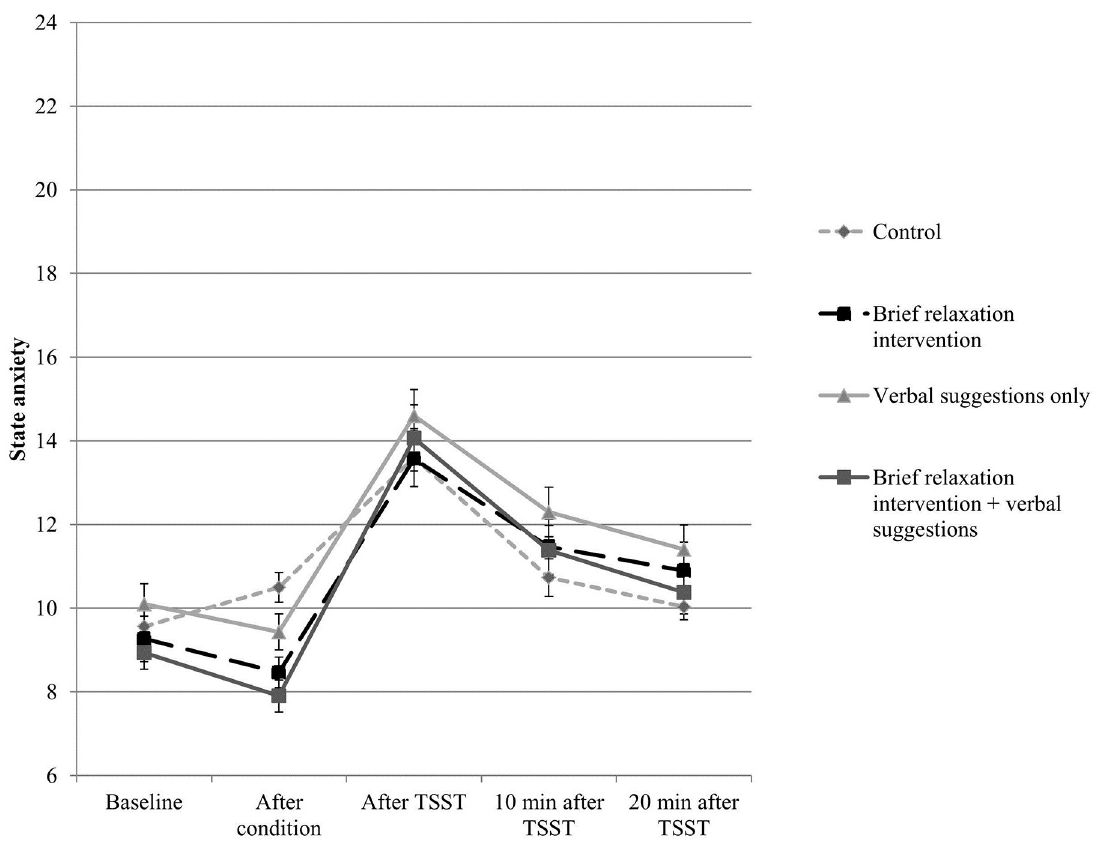
Fig 2. State anxiety levels for the four conditions on the various time points. The x-axis represents the various time points, whereas the y-axis represents the level of self-reported state anxiety. A higher score on the y-axis represents a higher level of state anxiety.